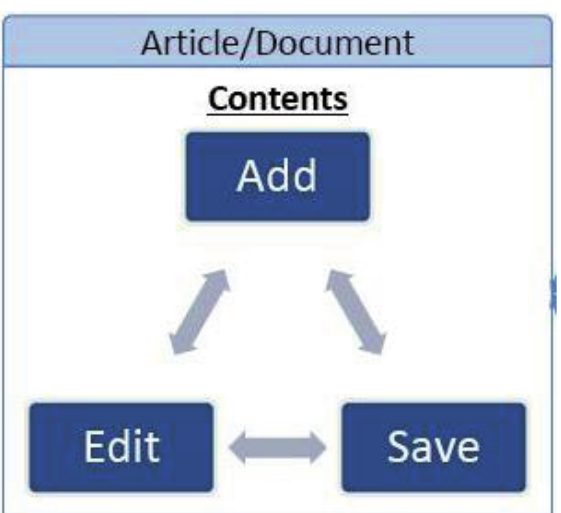
Figure 1: The creation and modi fi cation of knowledge and information in